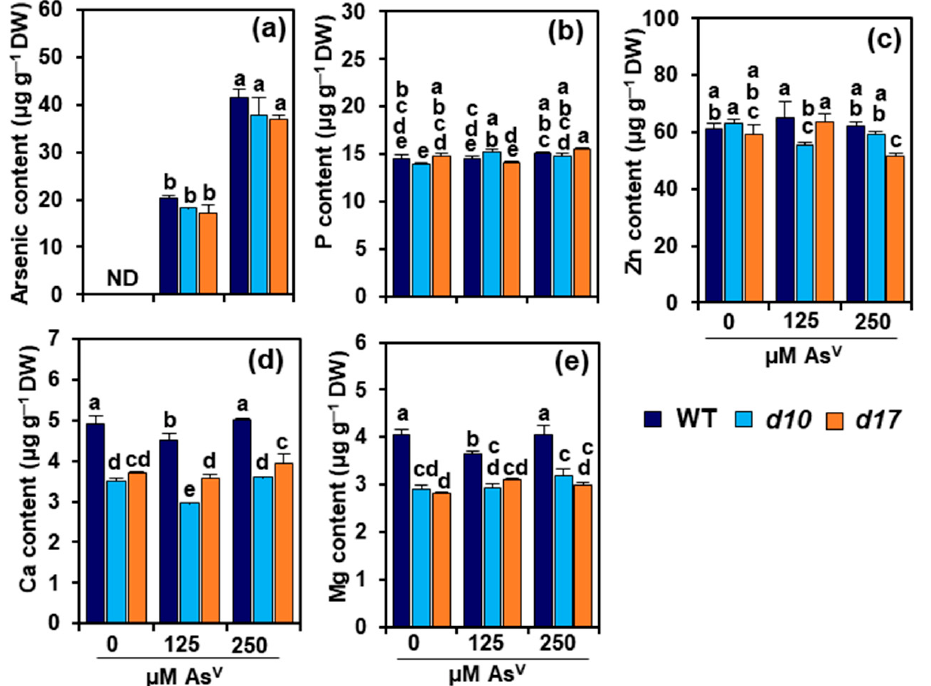
Figure 3. Arsenic and mineral nutrient contents in wild-type (WT) and d10 and d17 mutant plants exposed to different concentrations of sodium arsenate (Na 2 AsO 4 ; 0, 125 and 250 µ M As V ). The contents of arsenic ( a ), phosphorus (P) ( b ), zinc (Zn) ( c ), calcium (Ca) ( d ) and magnesium (Mg) ( e ) in rice shoots were determined on day 3 of As V treatments. Represented numerical data are the means with standard errors ( n = 4 biological repeats). Significant differences ( p < 0.05) among the treatments are denoted by distinct alphabetical letters according to a least significant difference test. DW, dry weight; ND, not